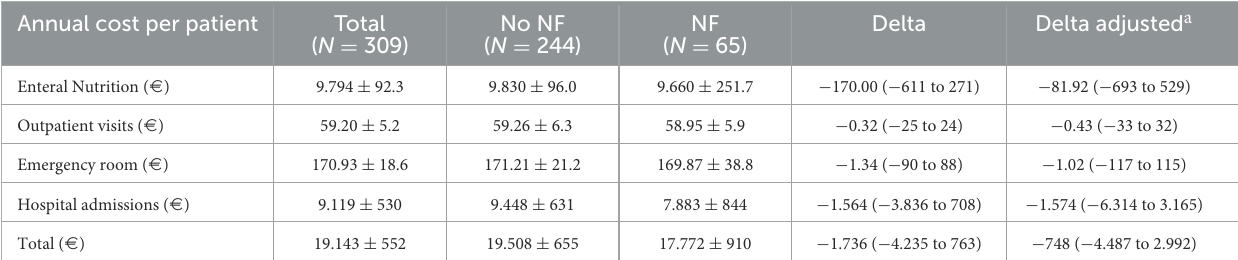
TABLE 2 Cost analysis based on annual rates in study cohort.